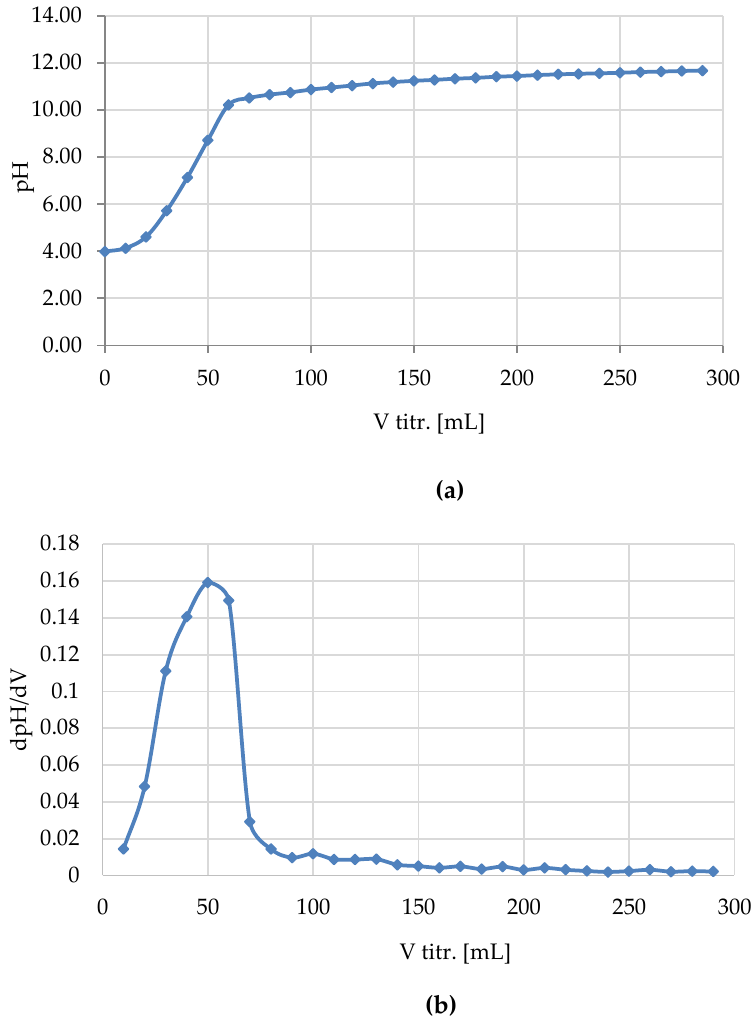
Table 8. The results of elemental analysis of Cell-O 6 -P(O)(OH)-H samples. Scheme 100.